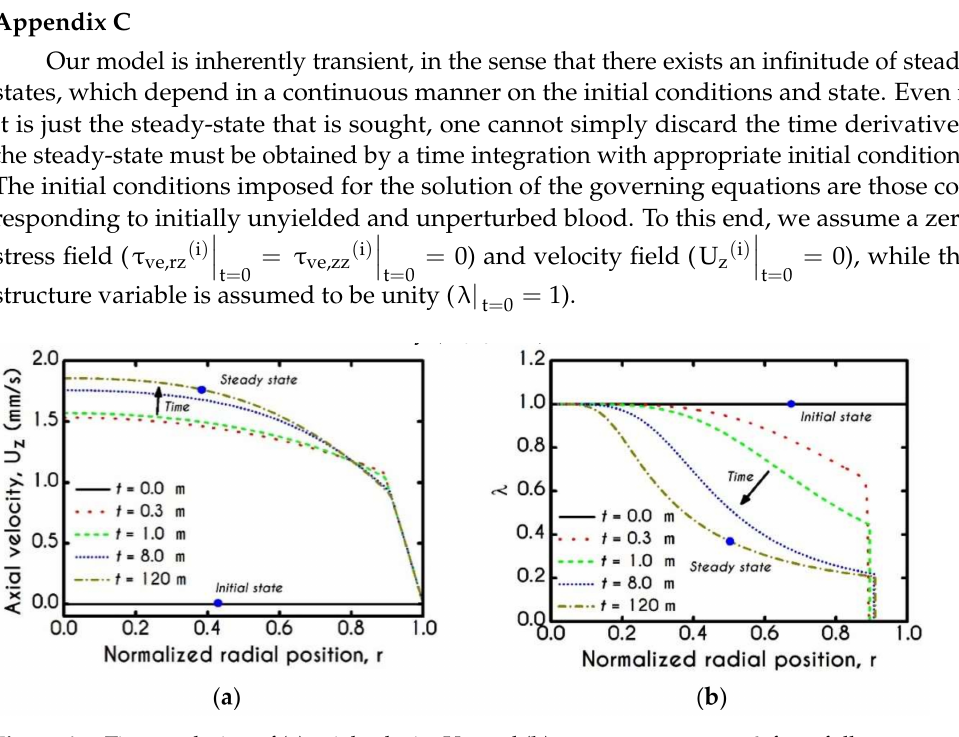
Figure A2. Time evolution of ( a ) axial velocity U z , and ( b ) structure parameter λ from fully structured state to